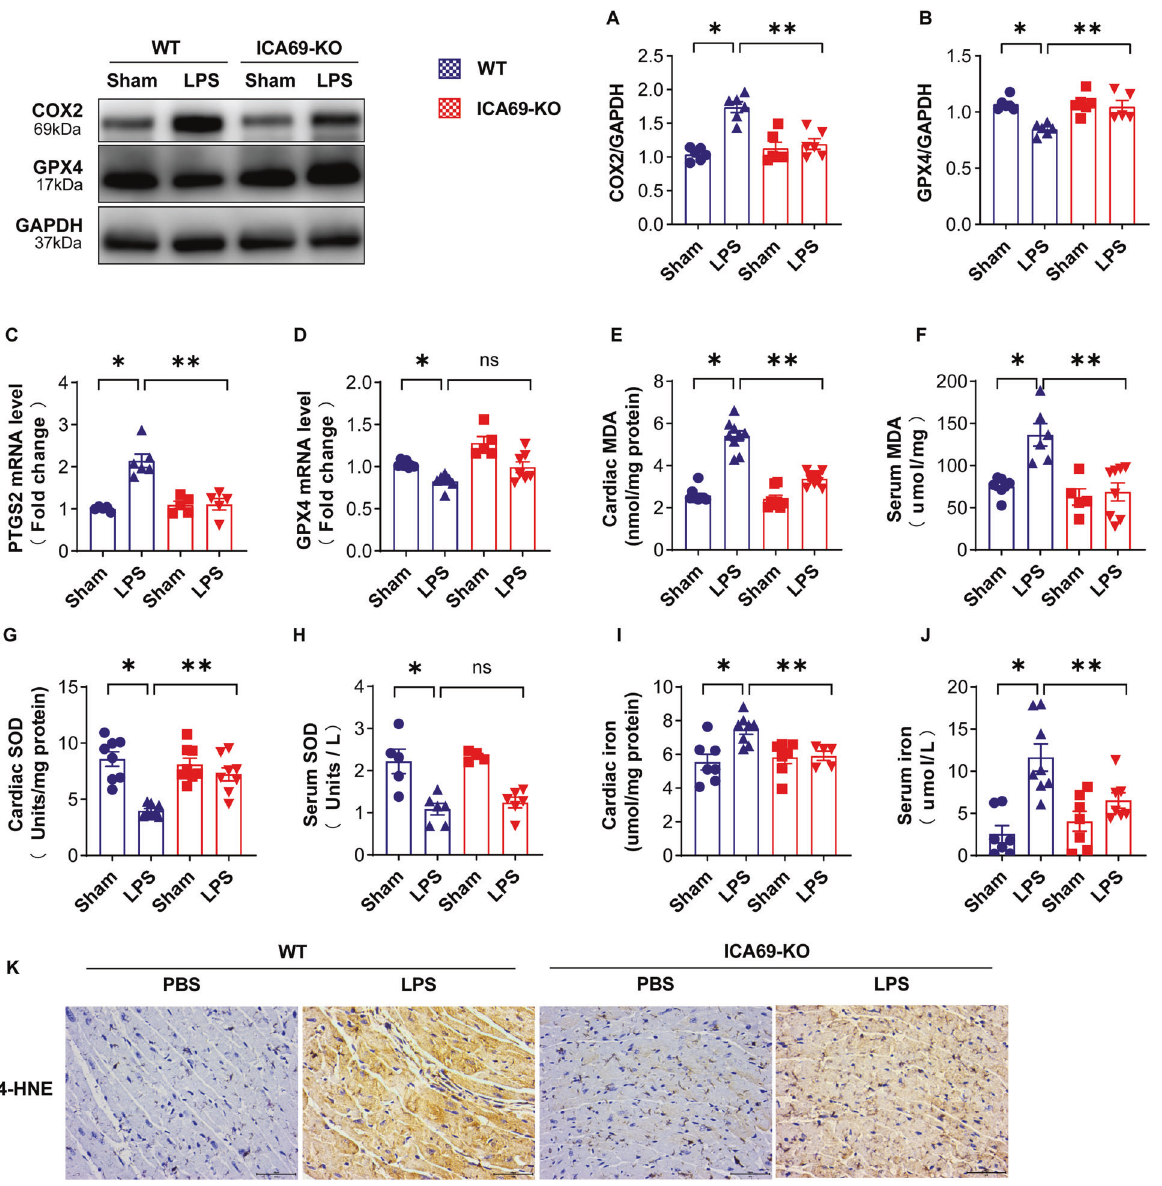
Fig. 4 Veri fi cation of ferroptosis markers in ICA69-/- mice with sepsis-induced cardiac injury. A , B Representative immunoblots and densitometric analysis of total COX2 and GPX4 in cardiac tissue of ICA69-de fi cient (KO) and wild-type (WT) mice after LPS challenge. Levels of total COX2 and GPX4 intensity were normalized to the corresponding GAPDH level, and the changes are shown in the histograms ( n = 6). C , D The mRNA levels of PTGS2 and GPX4 in the indicated groups ( n = 6). E , F The level of MDA in the indicated groups in cardiac tissue and serum ( n = 8/6). G , H The level of SOD in the indicated groups in cardiac tissue and serum ( n = 8/6). I , J The level of iron in the indicated groups in cardiac tissue and serum ( n = 6/7). The data are expressed as the mean ± standard error of the mean. * P < 0.05 vs. WT + LPS group, ** P < 0.05 vs. KO + LPS group, ns no signi fi cance. K Immunohistochemistry staining for 4-HNE protein ( n = 3 biologically independent